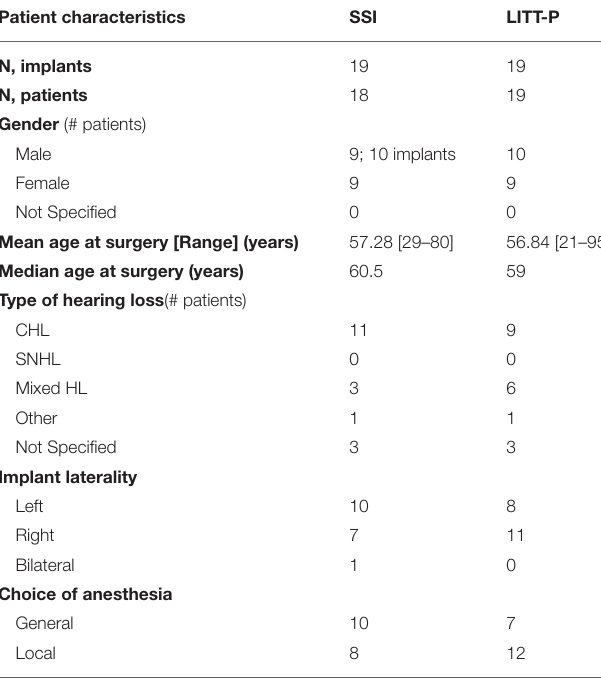
TABLE 3 | Skin reactions and postoperative